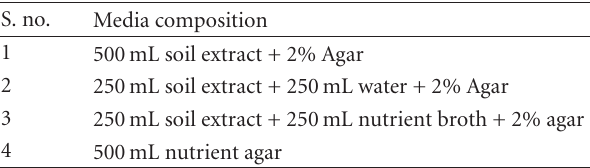
Table 1: The composition of di ff erent media designed. S.